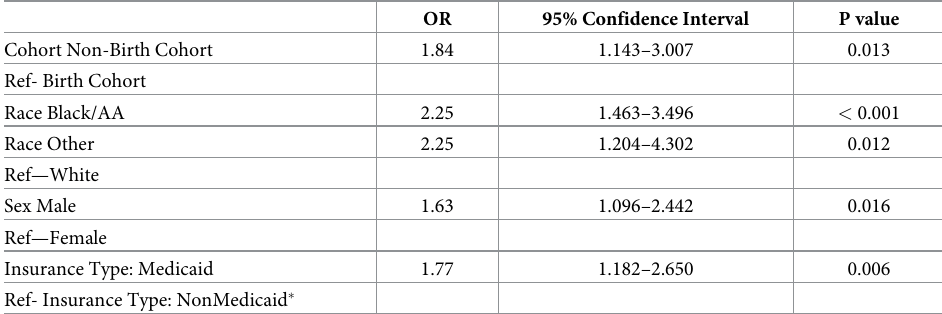
Table 4. Multivariable analysis: Association with HIV